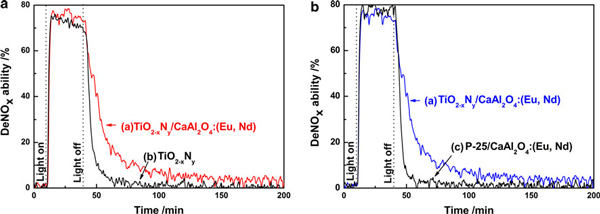
The photocatalytic deNOx activity of the prepared samples during UV light irradiation for 30 min followed by turning off light, while NO gas was continuously flowed in the dark for 3 h. a CaAl2O4:(Eu, Nd)/TiO2-xNy composite; b brookite phase TiO2-xNy; c CaAl2O4:(Eu, Nd)/undoped TiO2 (P25) composite.